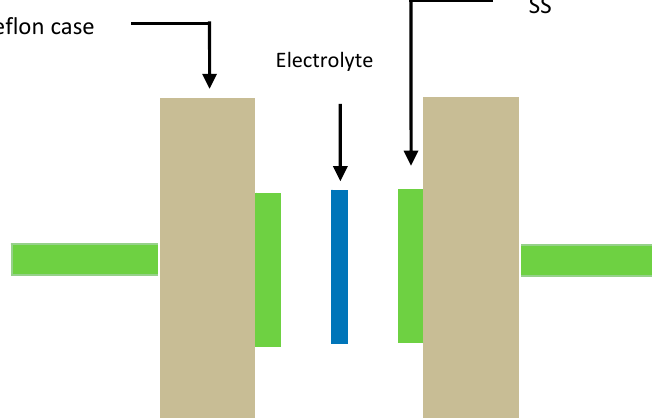
Figure 1. Schematic appearance of the cell used for the LSV and TNM measurements.